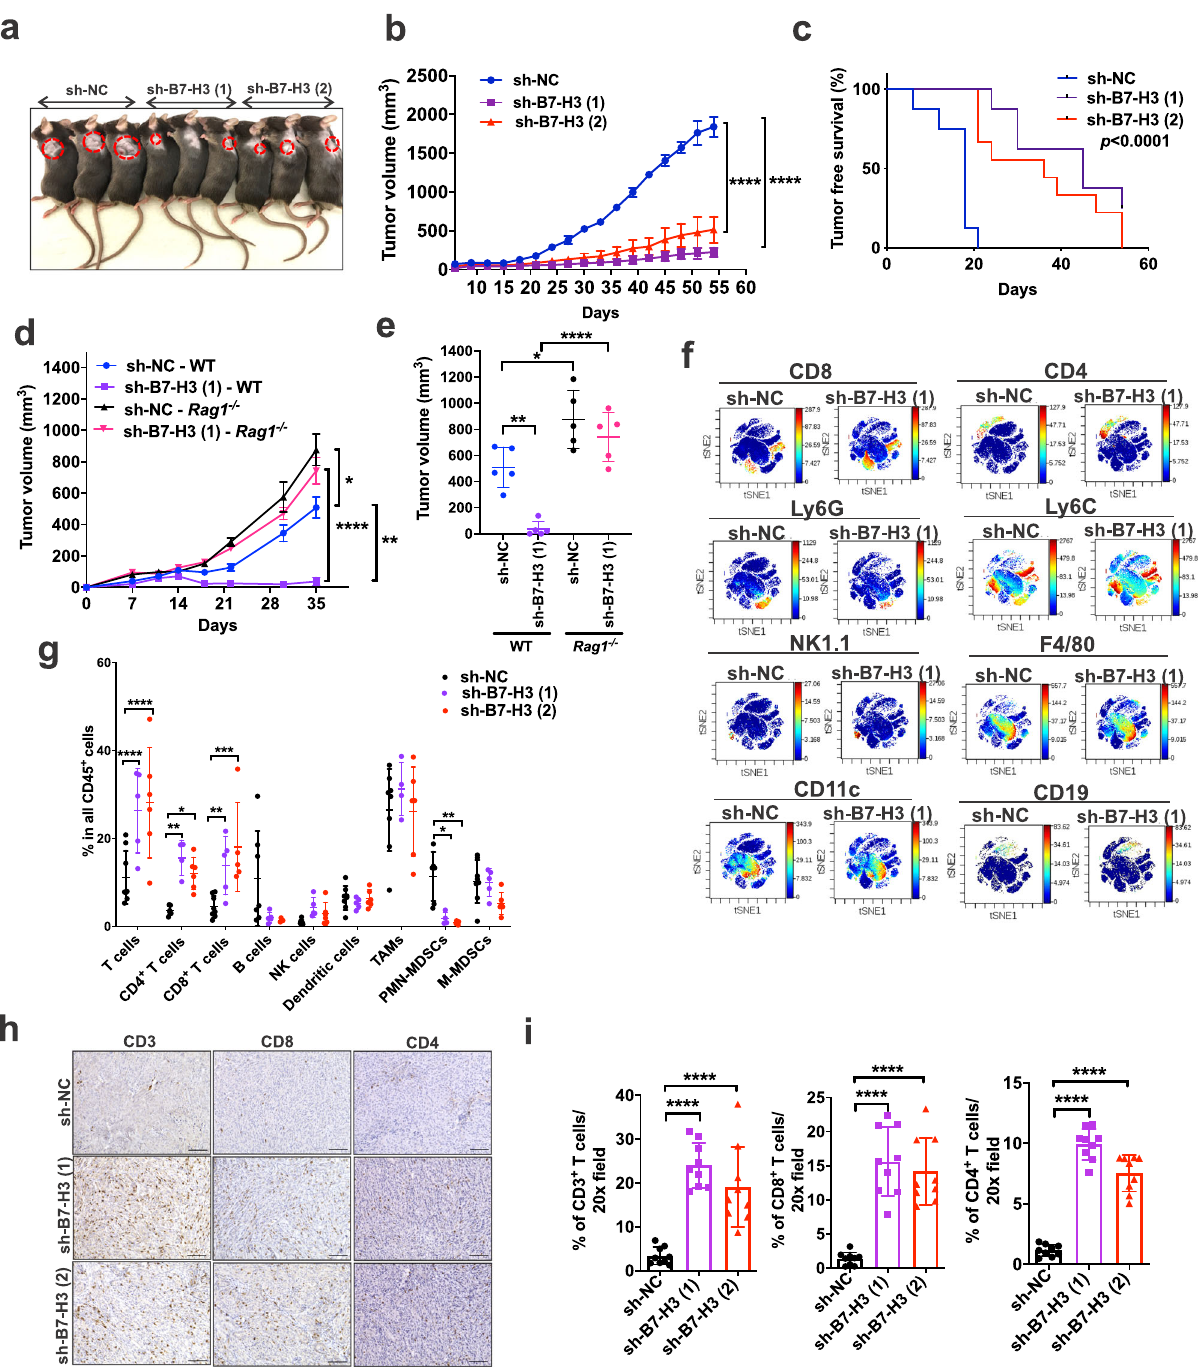
Fig. 5 | Suppression ofTsc2-null tumor growth by inhibiting B7-H3 requires an intact adaptive immune system. a Knockdown of B7-H3 using two different shRNAs in Tsc2 − / − 105K cells inhibits subcutaneous tumor growth in syngeneic wild-type (WT) C57BL/6J mice compared with non-targeting shRNA (sh-NC). b Growth of subcutaneous sh-NC, sh-B7-H3 (1), and sh-B7-H3 (2) Tsc2 − / − 105K tumors in WT C57BL/6J mice. n =8 mice/group, means±SD, one-way ANOVA with Holm-Sidak ’ smultiplecomparisonstest,**** p <0.0001. c Tumor-freesurvivalcurve of mice in b . Log-rank analysis. d Growth of subcutaneous sh-NC or sh-B7-H3 (1) Tsc2 − / − 105K tumors in WT or Rag1 − / − C57BL/6J mice. n =5 mice/group, means± SEM, two-way ANOVA with Holm-Sidak ’ s multiple comparisons test, * p <0.05, ** p <0.01 **** p <0.0001. e Tumor volume of d 35-day post cell inoculation. n =5 mice/group,means±SD,two-wayANOVAwithHolm-Sidak ’ smultiplecomparisons